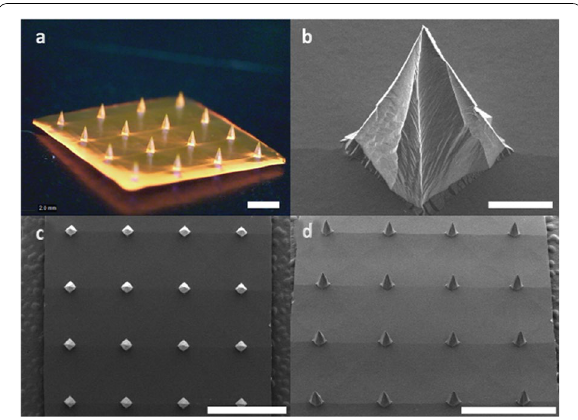
Fig. 3 Images of PVP‑MAA MN patch. a Optical image of 4 patch containing Rhodamine B (scale bar of a single MN (scale bar bar 2 mm) ( c , d =